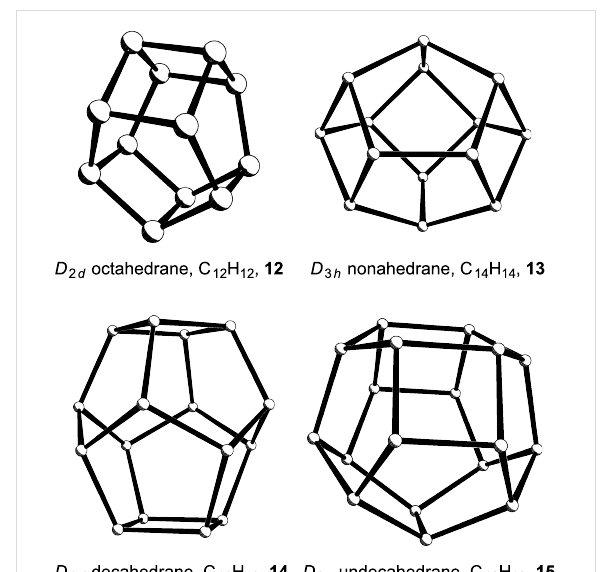
Figure 4: The as yet unknown polyhedranes 12 – 15